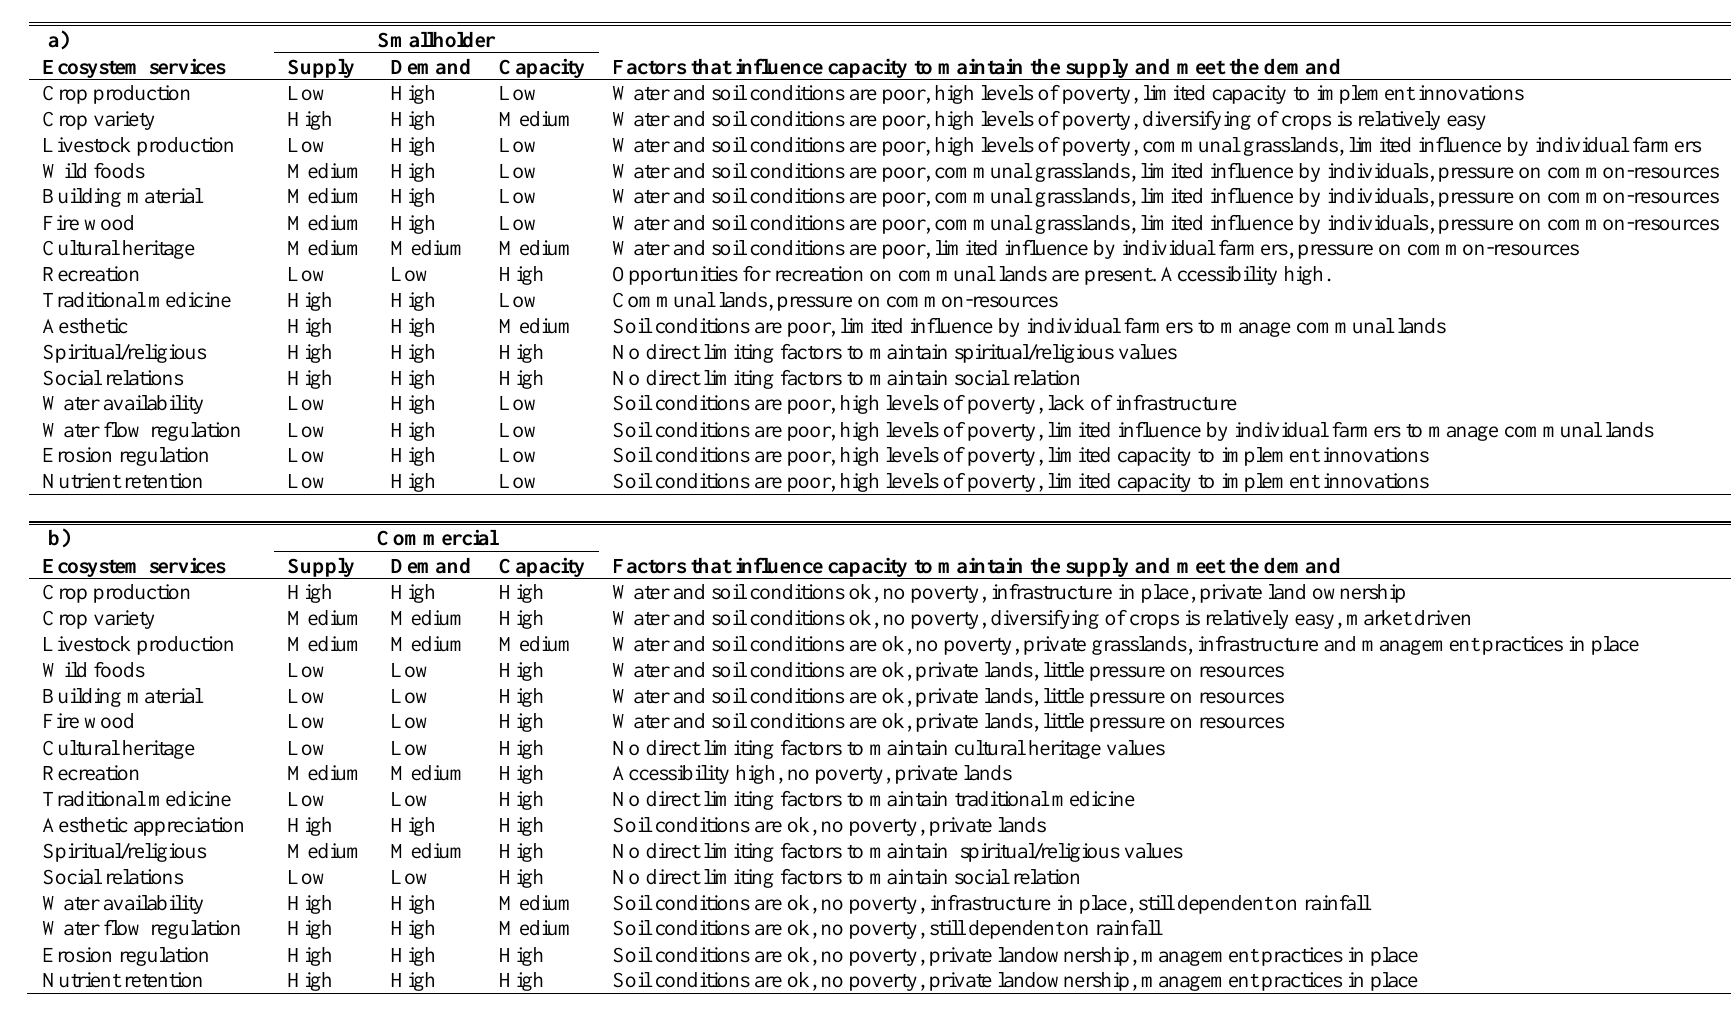
Table A1.3. Detailed description of factors used as criteria for the estimation of the farmers groups’ capacity to maintain the supply and meet the demand of services: a) smallholder, b)